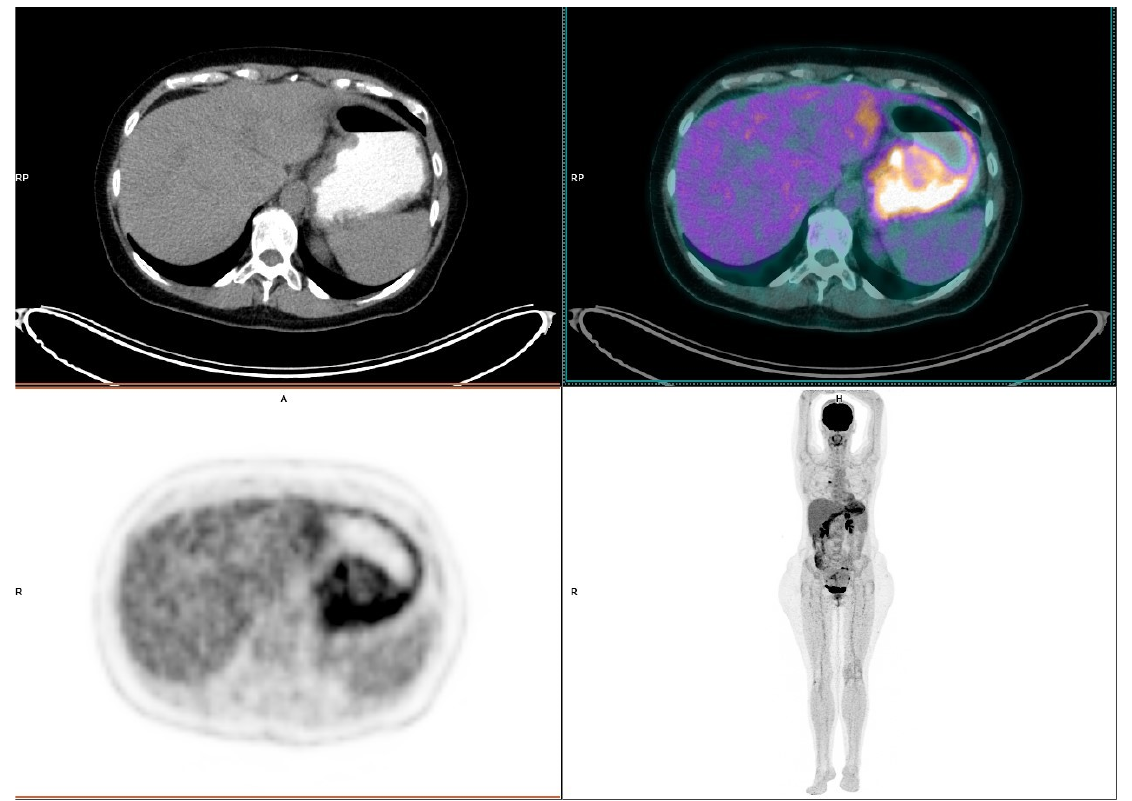
Figure 1. PET/CT, evaluating the metastatic melanoma status revealing intense metabolic uptake in the stomach. the